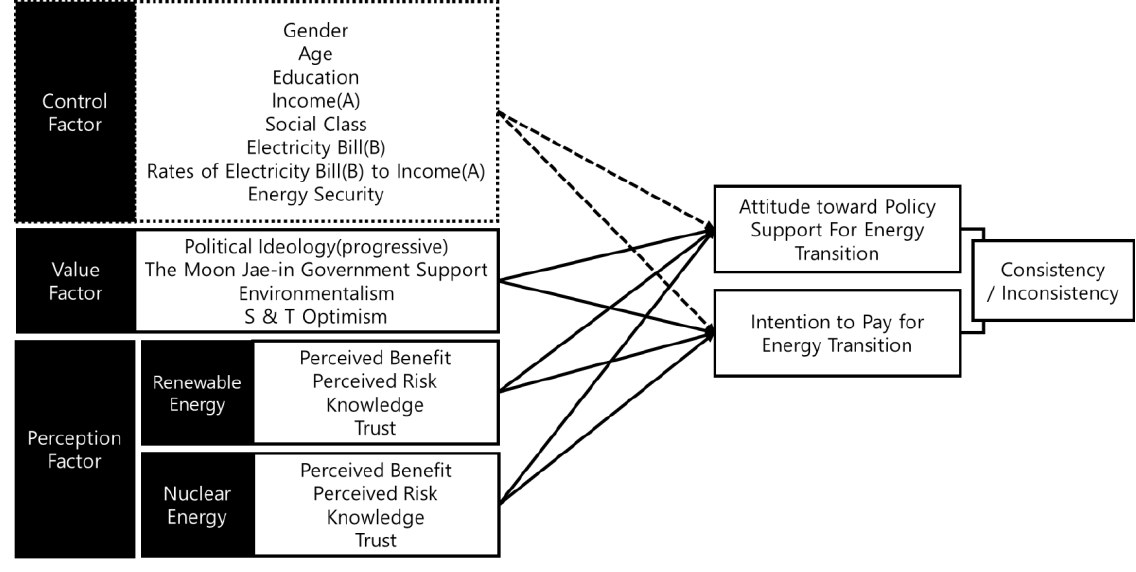
Figure 1. Research model.